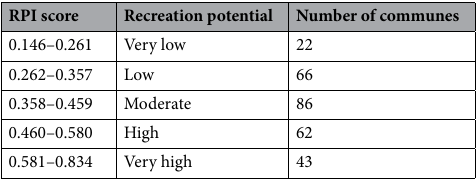
Table 3. Score ranges of RPI.